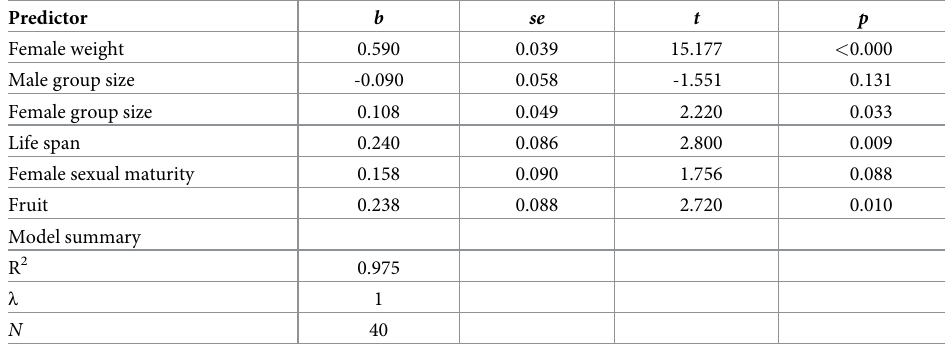
Table 1. The following model was selected with AIC for total brain size as the dependent variable. Predictor